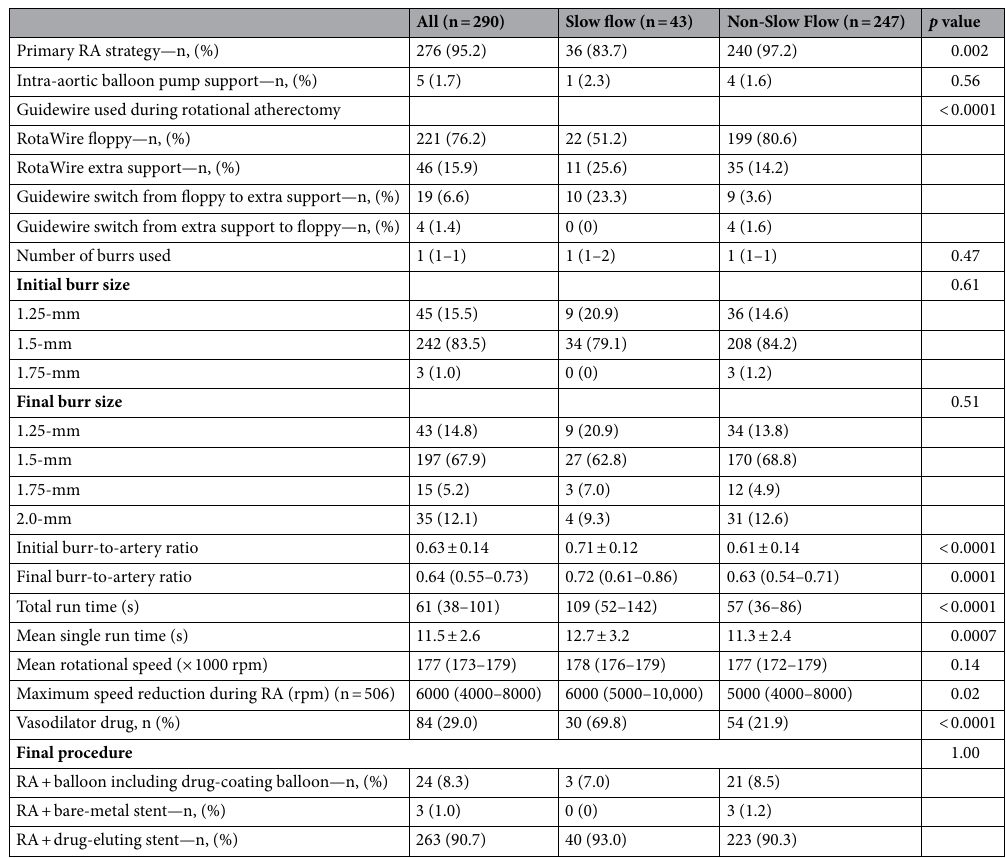
Table 2. Comparison of procedural characteristics and outcomes between the slow flow and non-slow flow groups. Values are presented as mean ± SD, median (interquartile range), or n (%) for categorical variables. IVUS intravascular ultrasound, RA rotational